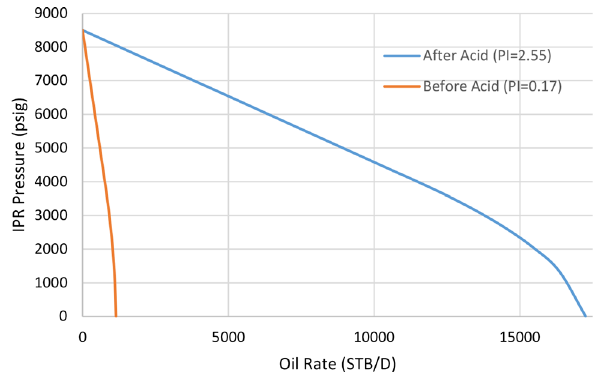
Fig. 4 The accelerating pace of productivity rate after acidizing (IPR curve)